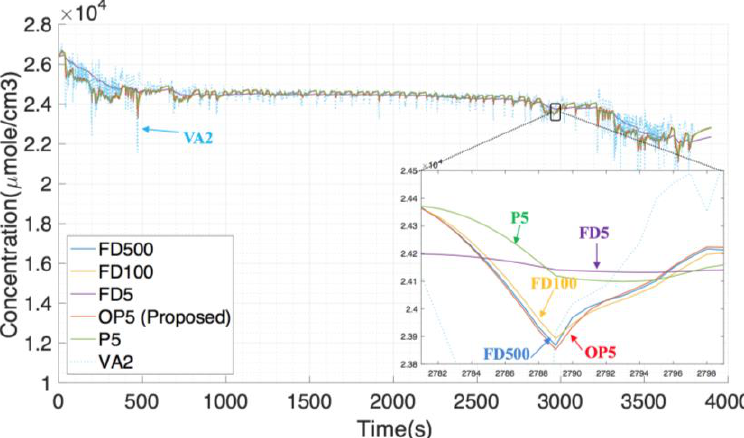
Figure 13. Federal driving schedule (FDS) profile ( a ), Fourier transform of FDS ( b ).